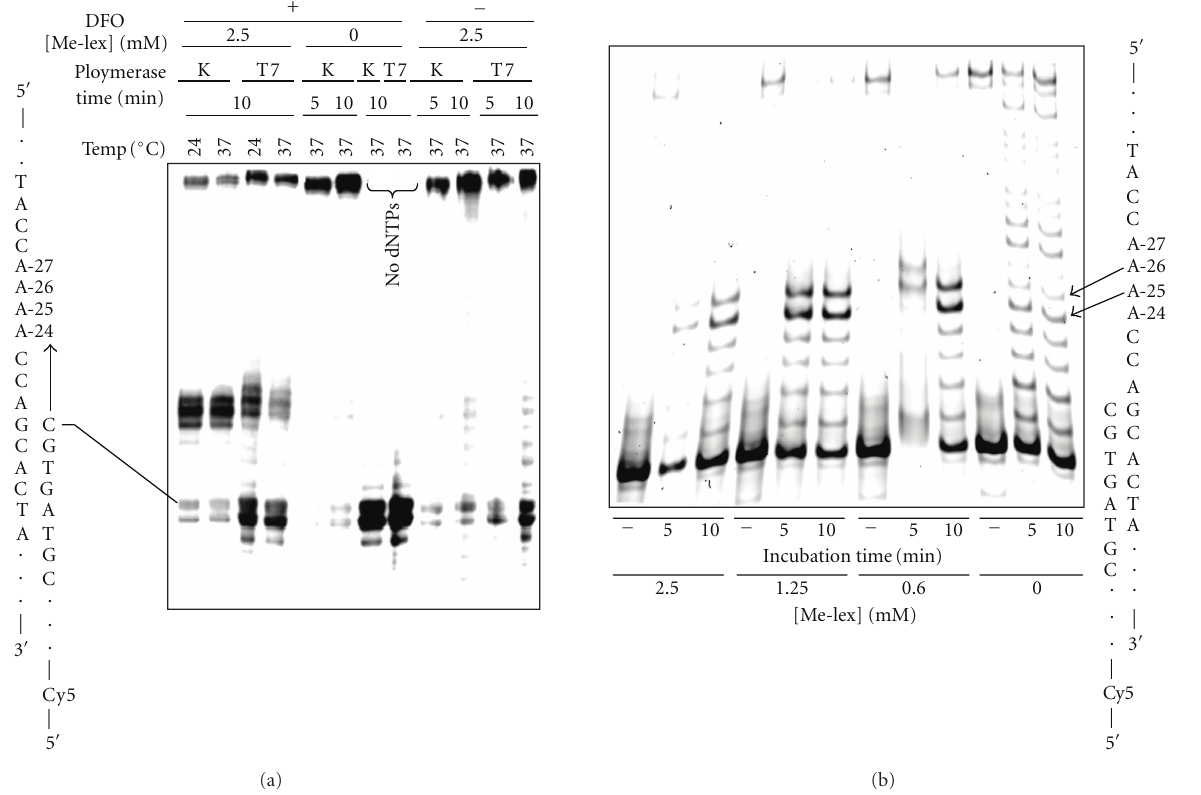
Figure 2: The 3-mA lesion blocks DNA polymerization by T7 Sequenase (T7) and Klenow fragment exo − (K) polymerase. (a) DNA template (100nM) was treated with 0 or 2.50 mM Me-lex for 12 hours at 4 ◦ C in the presence or absence of the DFO: 3-mA forms at A-26 and A-27 only when the DFO is present (Figure 1). The runup polymerization assay was initiated by raising incubation temperature to 24 or 37 ◦ C and the addition of 5 (cid:2) -Cy5-primer (200nM) and dNTPs (0 or 100 μ M). Polymerization experiments with T7 Sequenase and and Klenow fragment (exo − ) were run for 5 or 10 minutes. (b) The Me-lex (0, 0.6, 1.25 or 2.50mM) treated DNA was used to extend 5 (cid:2) -Cy5-primer in the absence ( − ) or presence of 100 μ M dNTPs for 5 or 10 minutes at 37 ◦ C using T7 Sequenase. The polymerase is blocked prior to insertion opposite positions-26 or -27, which are heavily methylated by Me-lex (Figure